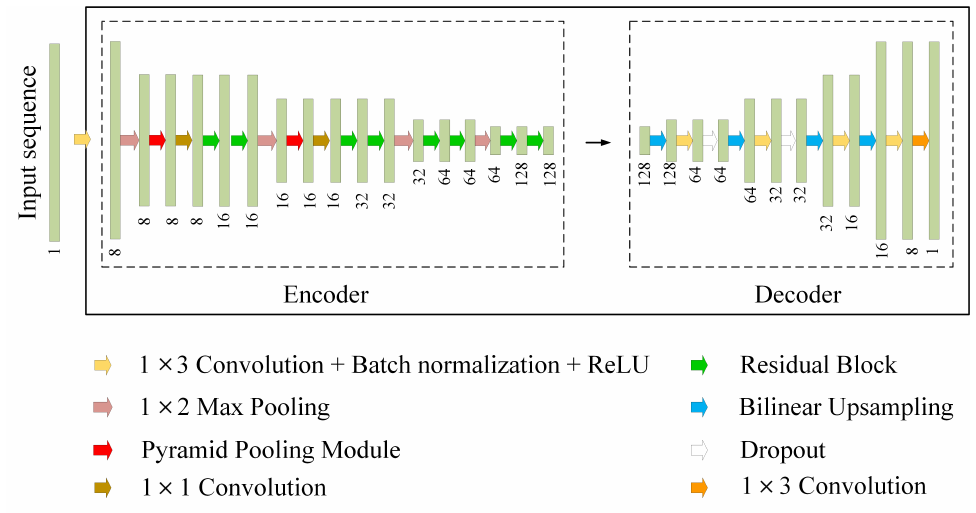
Figure 4. Overview of the proposed